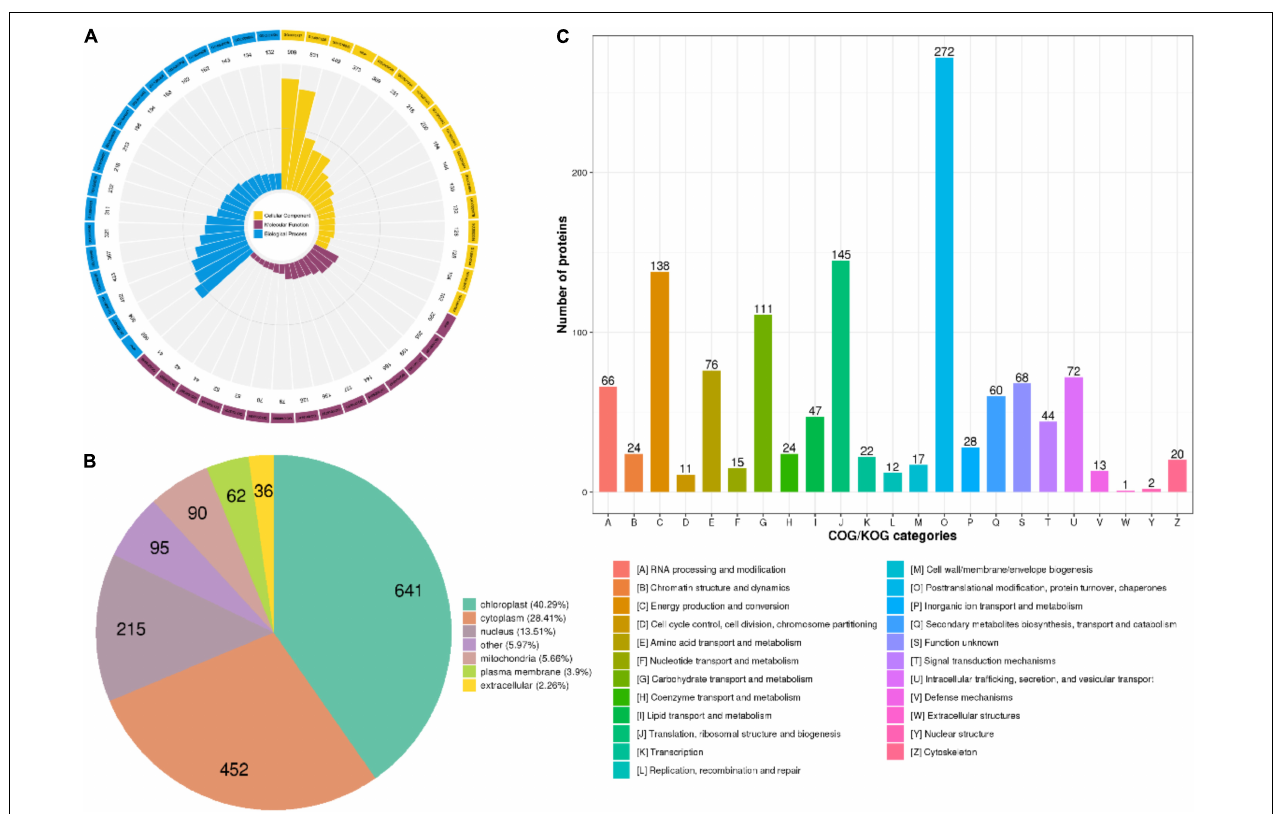
FIGURE 2 | Classification of proteins in D. huoshanense corresponding to identified sites. (A) The Gene Ontology (GO) classification of the crotonylated proteins in D. huoshanense based on biology process, cellular components, and molecular functional. (B) Subcellular localization chart of proteins corresponding to modification sites. (C) COG/KOG functional classification of crotonylated